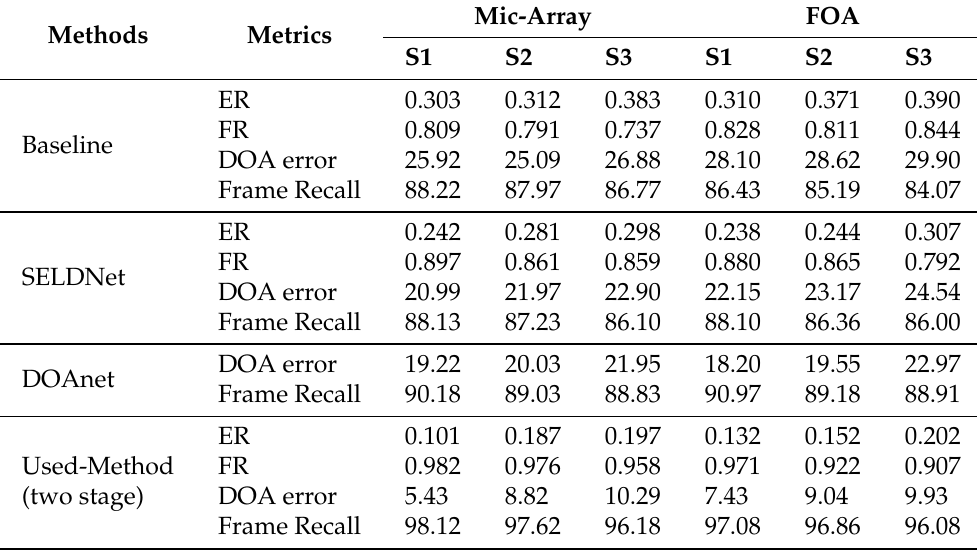
Table 4. Performance comparison between other similar methods and the proposed method in scenario-2 escalator descending direction.